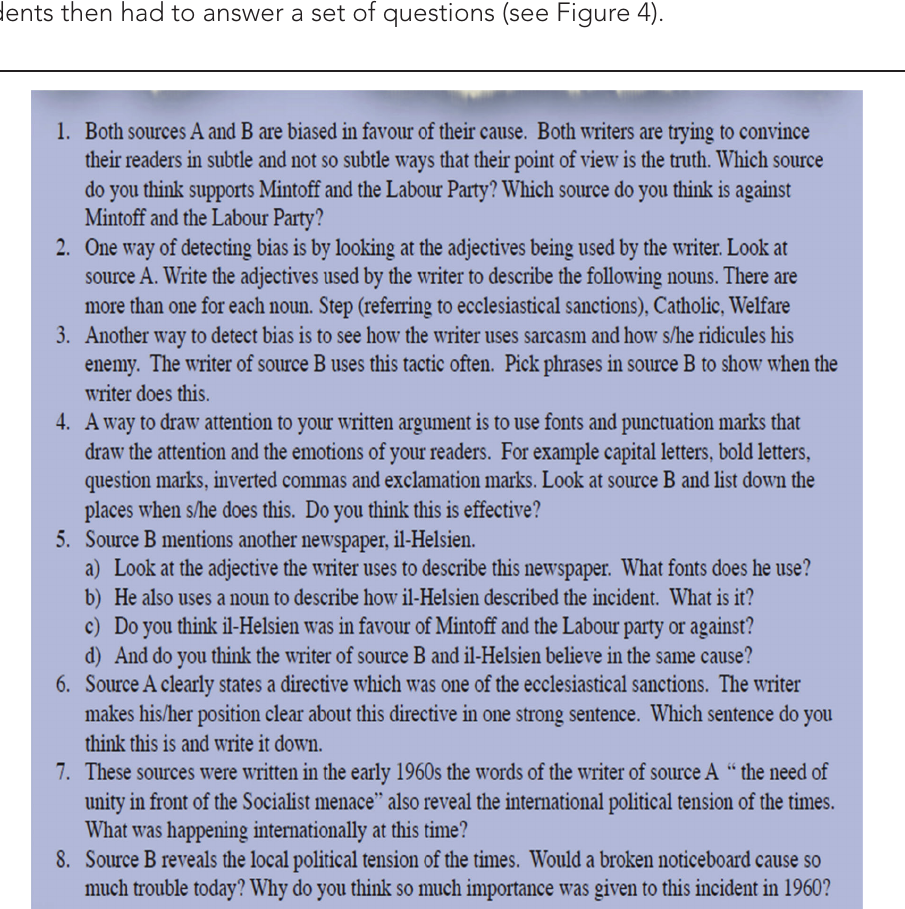
Figure 3: Source B Source : Vella (2008: 75–6) Students then had to answer a set of questions (see Figure 4).